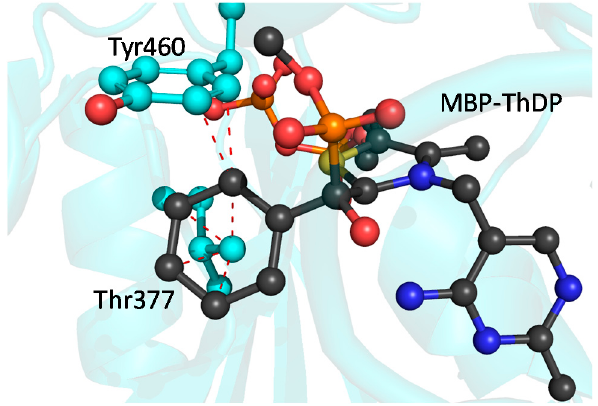
Figure 5. BFDC T377L/A460Y with MBP ‐ ThDP (black) placed into the active site. Red lines indicate distances of <2.5 Å. Superposition carried out with PyMOL as described in Materials and Methods using MBP ‐ THDP data from PDB ID 3FSJ [41]